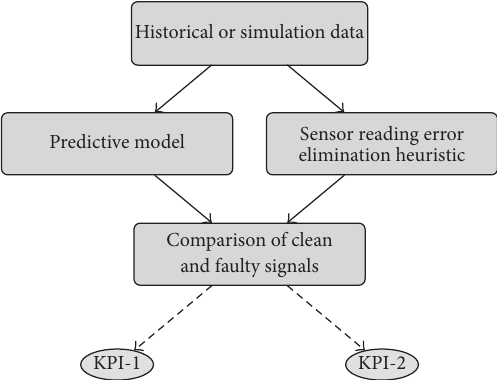
Figure 2: Sensor fault detection process